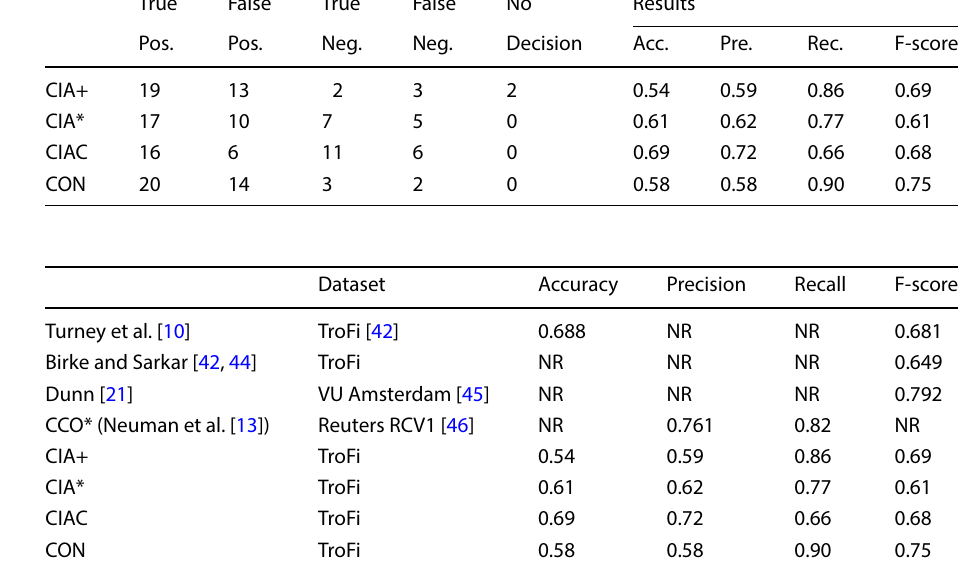
Table 3 Binary classifications and results: simple data